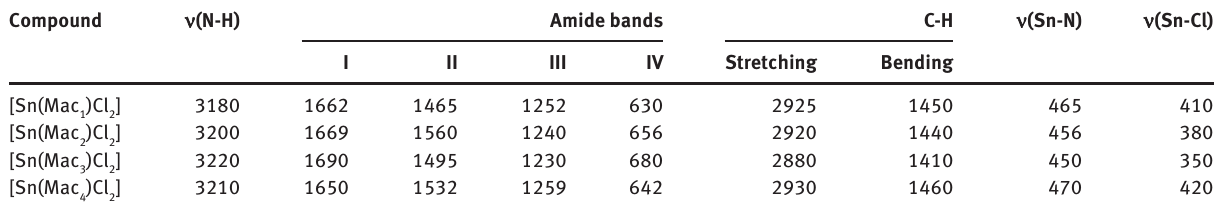
Table 2 IR spectral data (cm -1 ) of tin(II) macrocyclic complexes.